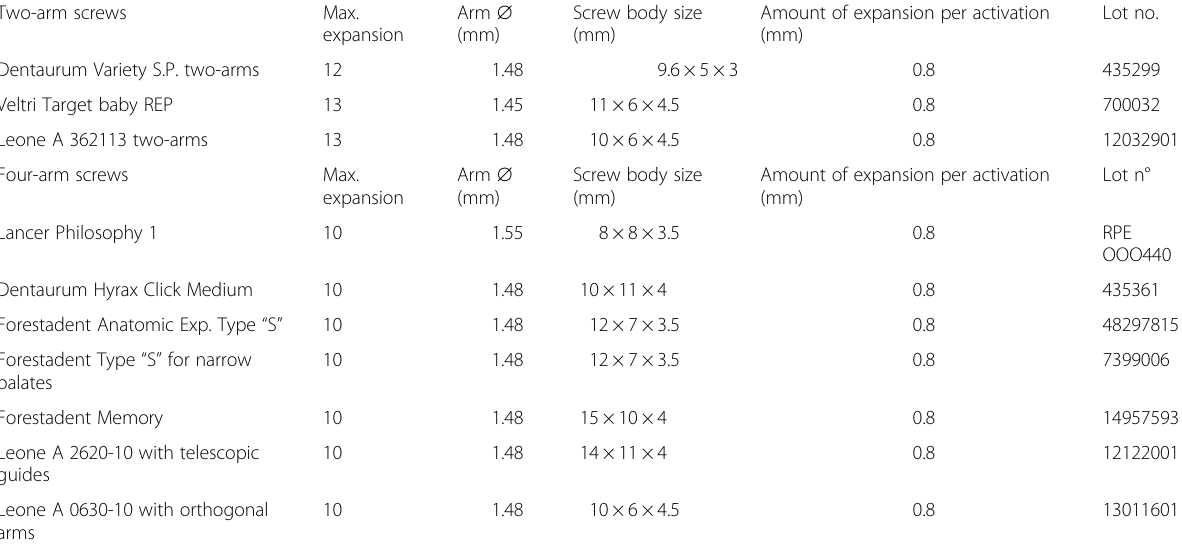
Table 1 Screw characteristics Two-arm